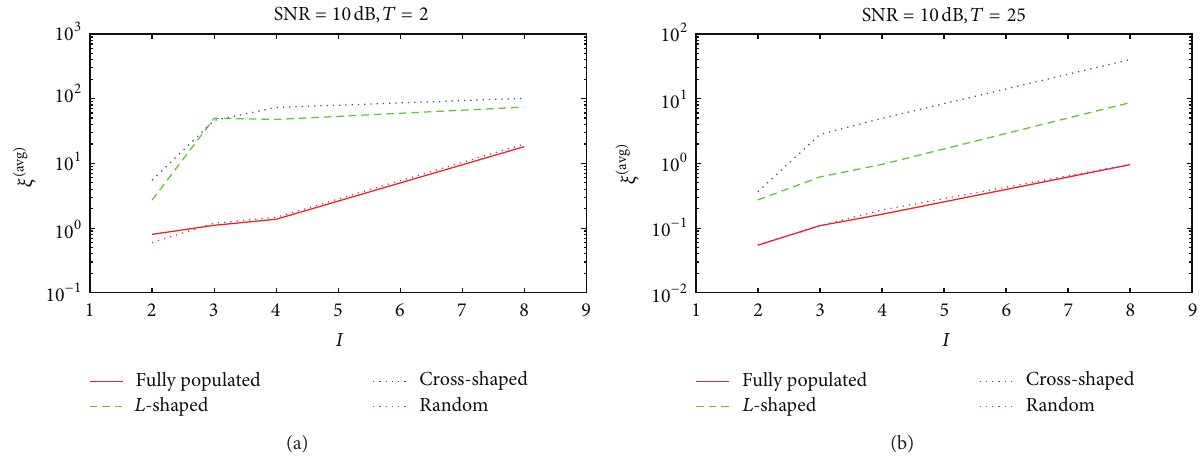
Figure 10: Array geometries comparison—( 𝑁 = {9,25} ; 𝑑 𝑥 = 𝑑 𝑦 = 0.5𝜆 ; 𝐼 ∈ [2 : 8] ; SNR = 10dB; 𝑇 = {2,25} ; 𝐶 = 50 )—behavior of the location index 𝜉 ( ave ) averaged among 𝐶 different noisy scenarios versus the number of arriving signals 𝐼 when using the MT-BCS with (a) 𝑇 = 2 snapshots and (b) 𝑇 = 25 snapshots.